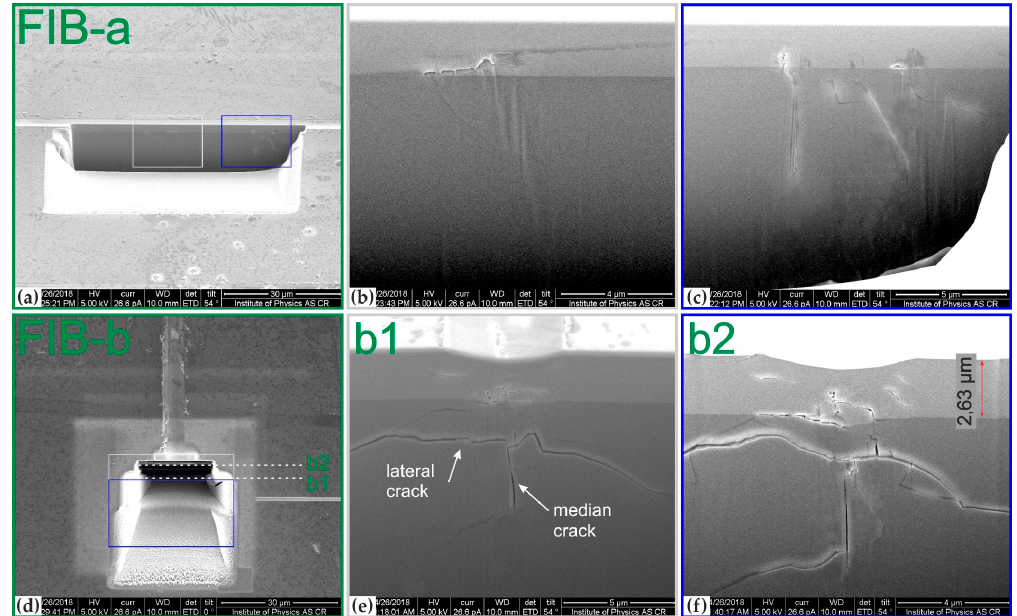
Figure 5. SEM images of the Focused Ion Beam (FIB) milled on the SiCN film for the( a ) longitudinal cross section in the area of L c1 with ( b , c ) details and ( d ) the perpendicular cross section of the final part of the residual scratch groove with ( e , f ) two successive cross-sections.